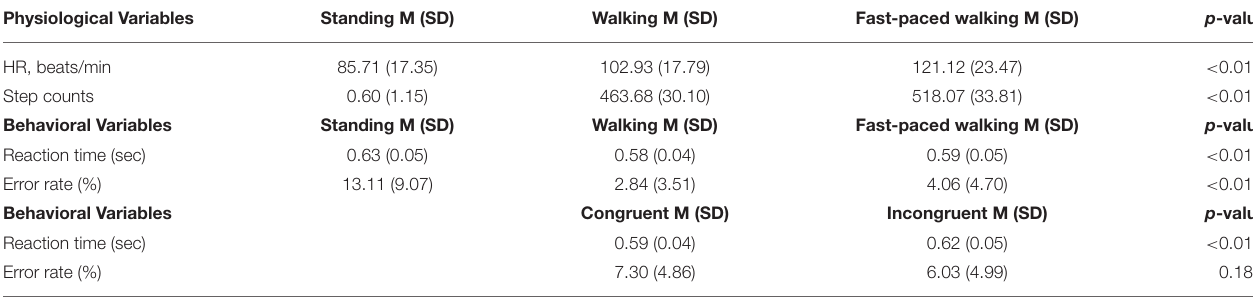
TABLE 2 | Physiological and Behavioral Measures. Physiological